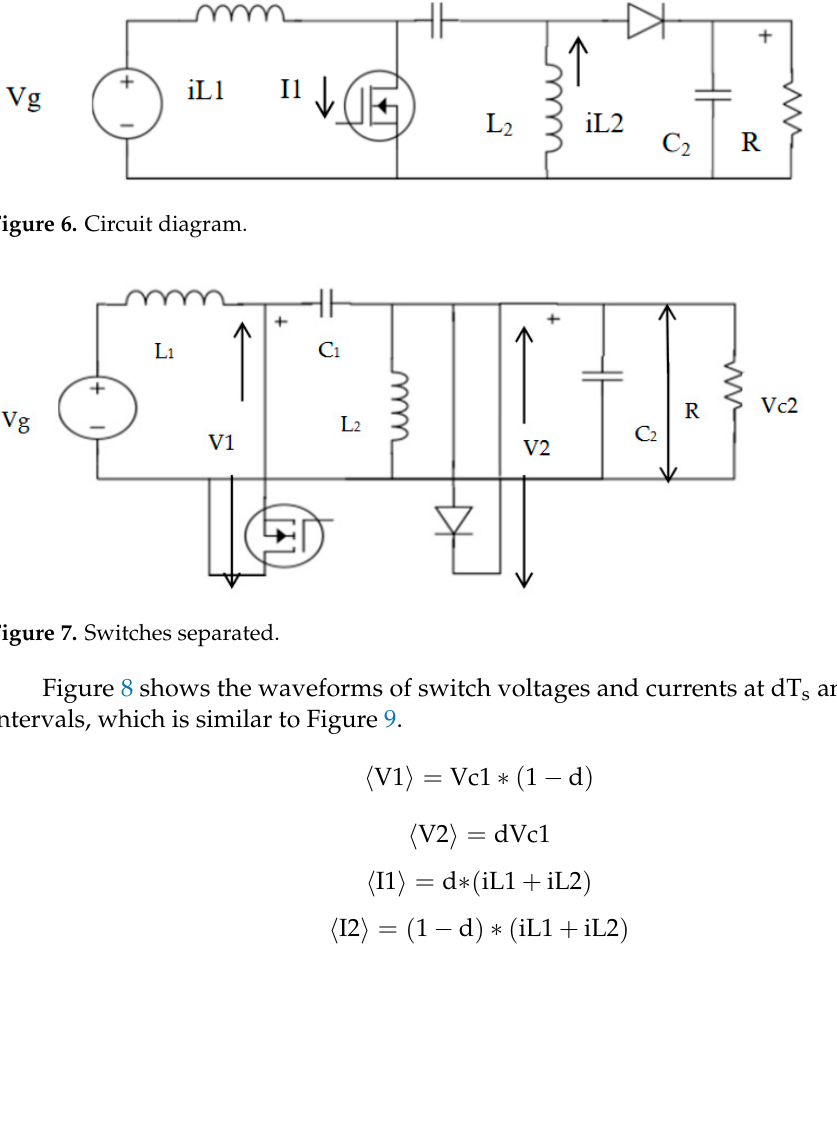
Figure 8. Waveforms during switch ON and OFF conditions.